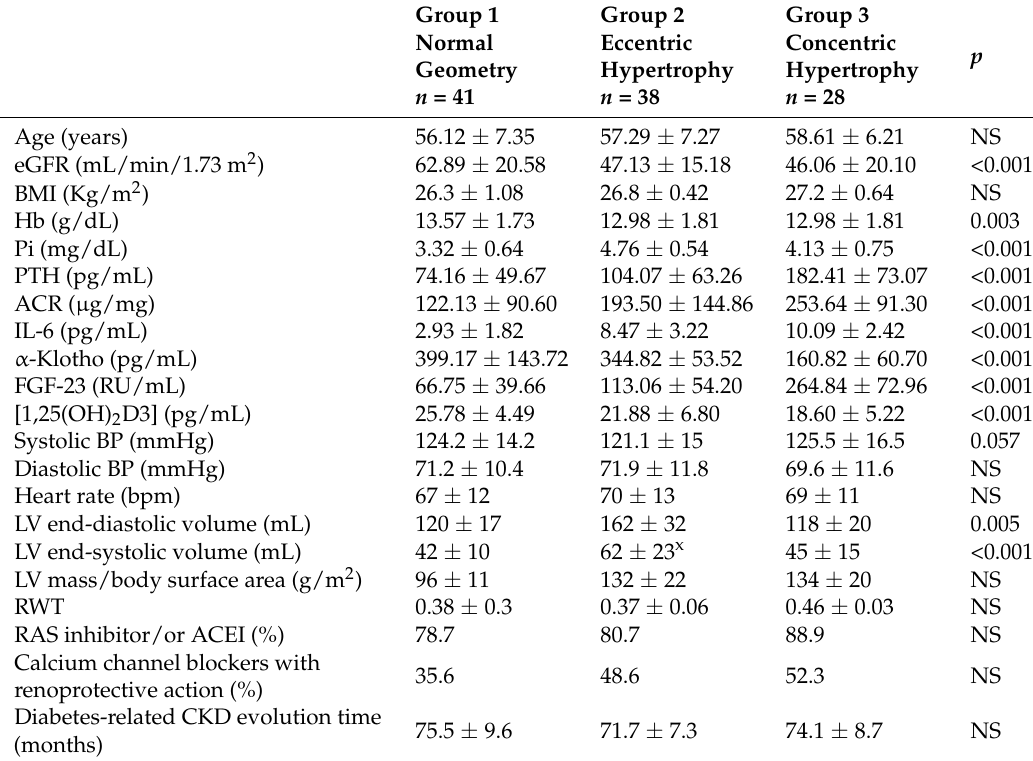
Table 2. Patient demographic and clinical characteristics at baseline according to level of cardiac hypertrophy.